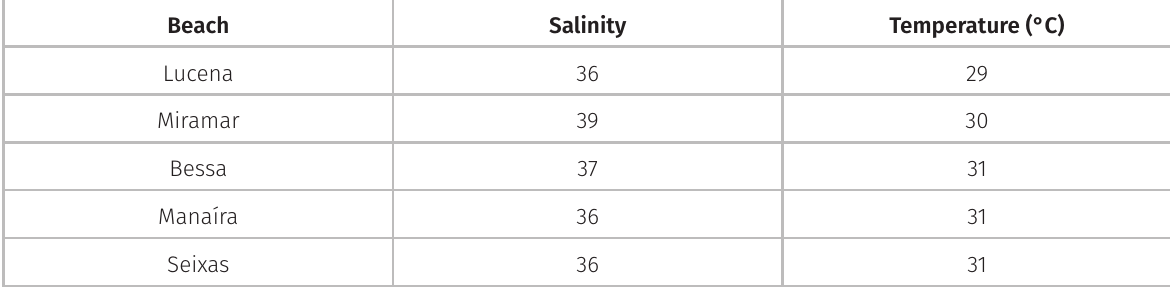
Figure 2. Relative contribution (%) of each granulometric fraction at different beaches from João Pessoa metropolitan area. Table I. Temperature and salinity of the studied